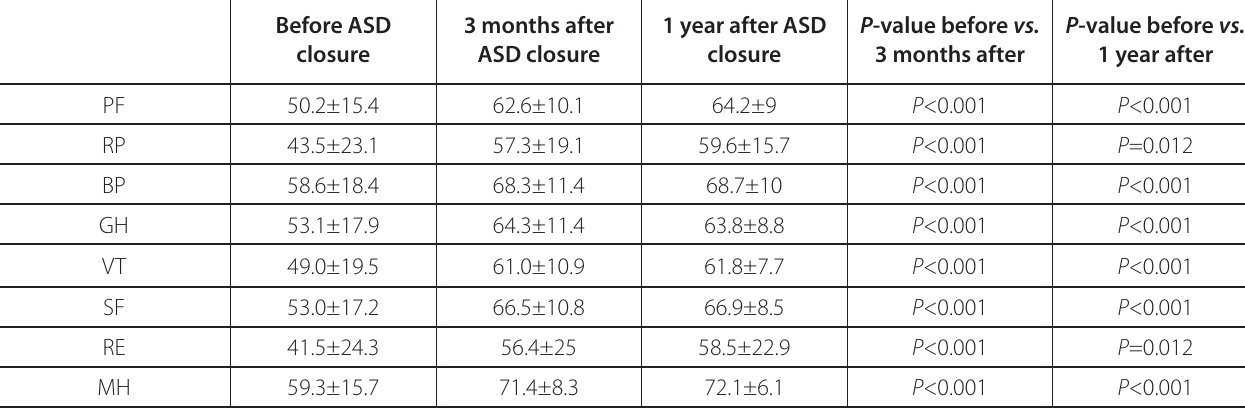
Table 3 . Result of SF-36 scores before and after ASD closure.